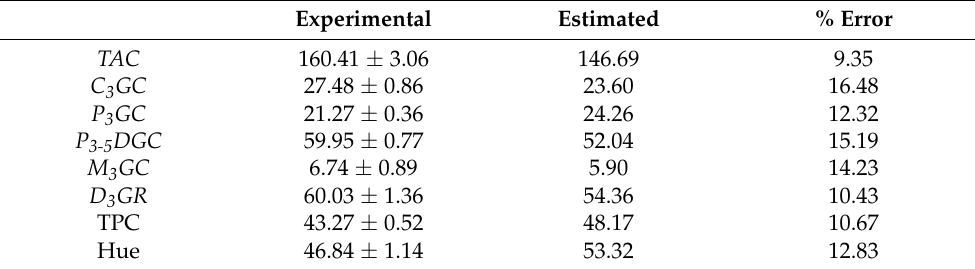
Table 5. Experimental and predicted values of the responses